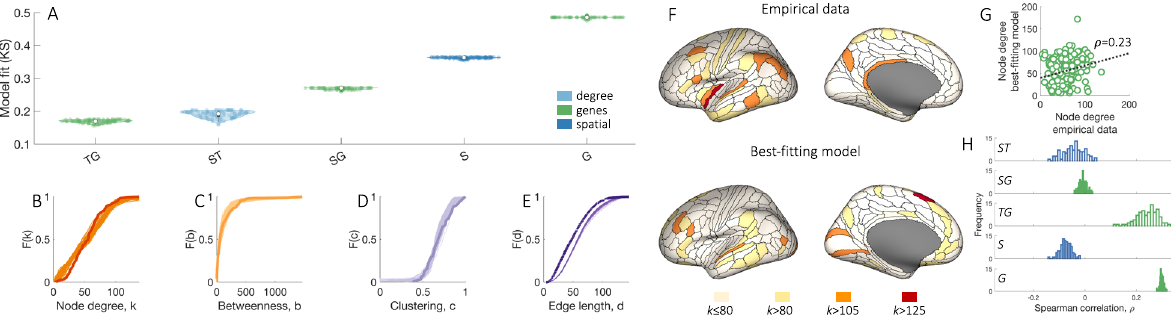
Fig. 5 Adding genetic constraints to generative models can improve fi ts to network topology and topography. A Each distribution represents estimates of model fi t, as quanti fi ed by the maximum KS value of the top 100 networks (out of 10,000) produced by the model optimization procedure. The color of each box indicates conceptually related models, as determined by the speci fi c metric used in the model: models favoring connectivity between regions with similar gene expression are in green, a model based on degree and wiring cost is in light blue, and a purely spatial model considering wiring costs alone is in dark blue. “ S ” , “ T ” , “ G ” stand for space (wiring cost), topology, and gene expression, respectively. White dots represent median values for each distribution. Interquartile range is represented with a dark gray box, whiskers are represented with a light gray line. Cumulative distributions of B node degree, k ; C betweenness centrality, b ; D clustering coef fi cient, c ; and E edge length, d , for the empirical connectome (darker line) and 100 runs (lighter lines) of the best- fi tting “ TG ” model corresponding to the data points shown in A . F Anatomical locations of hubs de fi ned for a single hemisphere at selected k thresholds for the empirical data (top) and the single run of the optimized “ TG ” generative model demonstrating the best model fi t across 10,000 runs (bottom). These networks contain 177 regions (instead of 180 presented in Fig. 4F) due to the limited coverage of gene-expression data. G Correlation between the degree sequences of the empirical data and the best- fi tting generative model within a single hemisphere (Spearman ’ s ρ = 0.23, p = 3.3 × 10 − 5 ). H The distributions of correlation values quantifying the relationship between left hemisphere degree sequences of the empirical data and synthetic networks generated using the top 100 best- fi tting parameter combinations for each of the 6 considered models, corresponding to the data points shown in A . Source data are provided as a Source Data fi